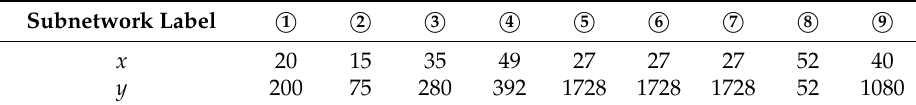
Table 1. The numbers of the relevant data with multivalued coefficients.